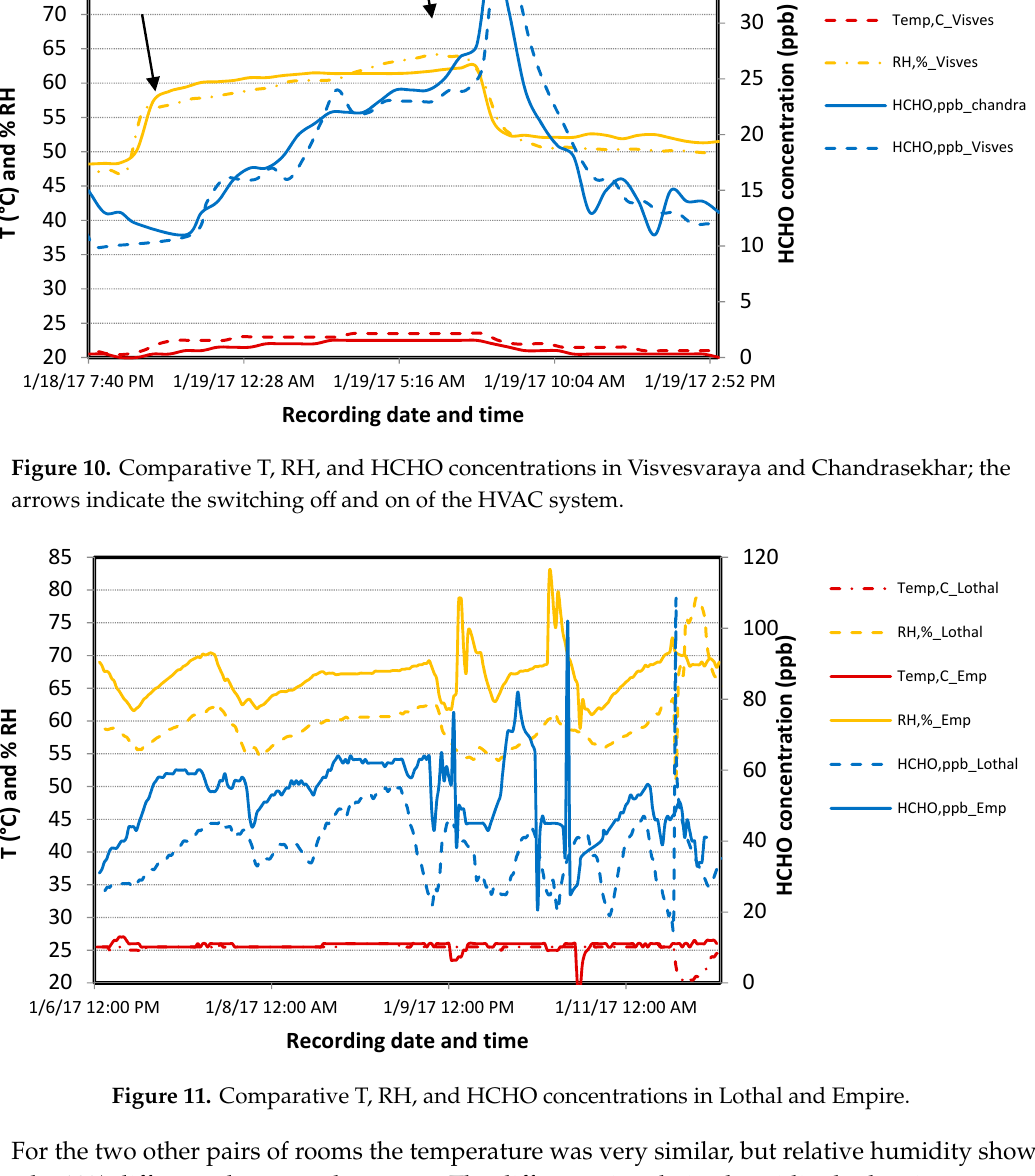
Figure 12. Comparative T, RH, and HCHO concentrations in Sydney and Takshasila. Based on these preliminary results, the recommendation was to continue with the Visvesvaraya and Chandrasekhar meeting rooms. Longer recordings were carried out. Those recordings took place from the end of January 2017 to the beginning of March 2017. Reference measurements on DNPH cartridges were done in parallel between 16 and 27 February. The cartridges were analyzed by an external laboratory. The corresponding results are displayed in Figure 13. Those longer periods of recording confirm that the two rooms display very similar behavior in terms of temperature, relative humidity, and formaldehyde concentration. Once again, the impact of the switching on or off of the HVAC system during weekdays and weekends can be systematically observed.